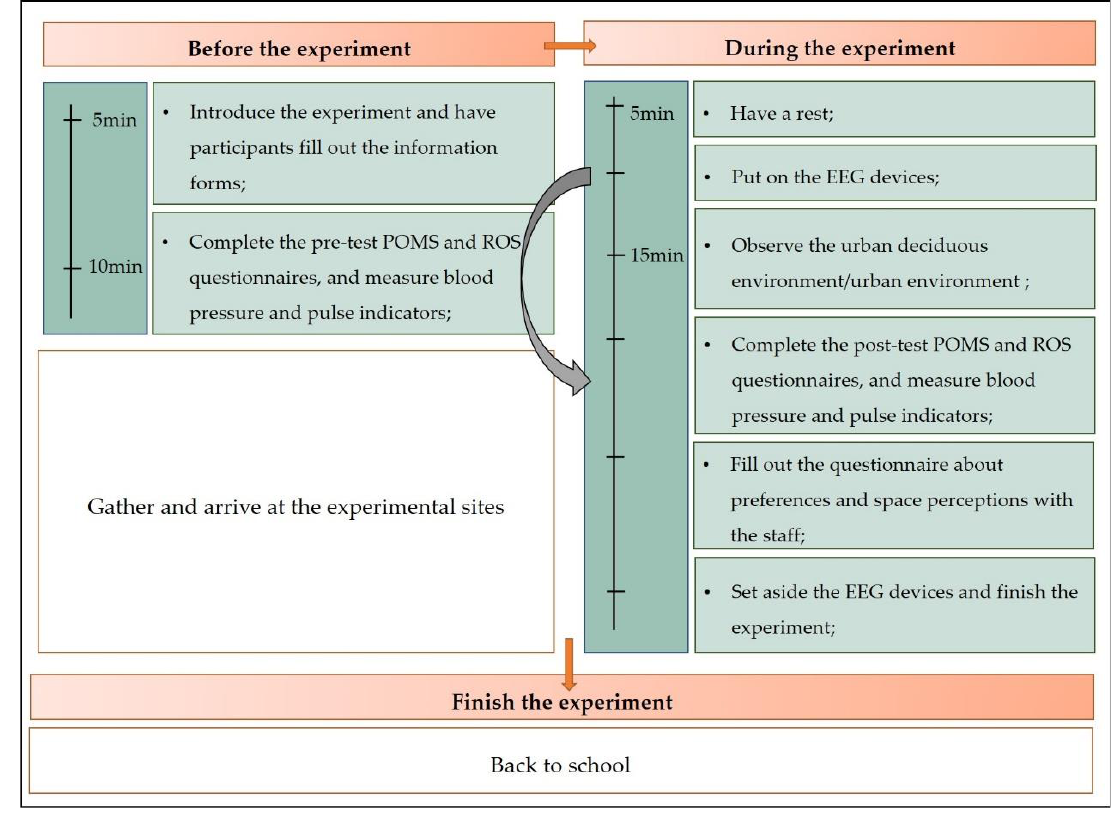
Figure 2. Experiment procedure (POMS = Profile of Mood States, ROS = Restorative Outcome Scale states, EEG = electroencephalogram). Table 1. Environmental factors of the three sites.